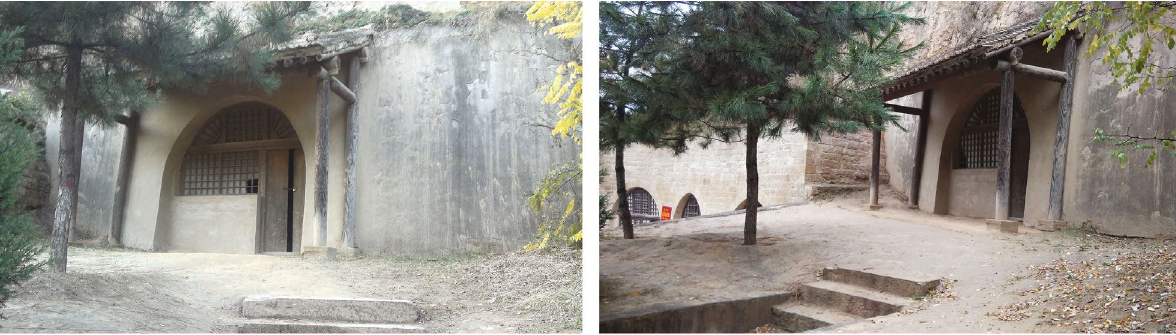
Figure 2: Single-hole cli ff -side loess cave